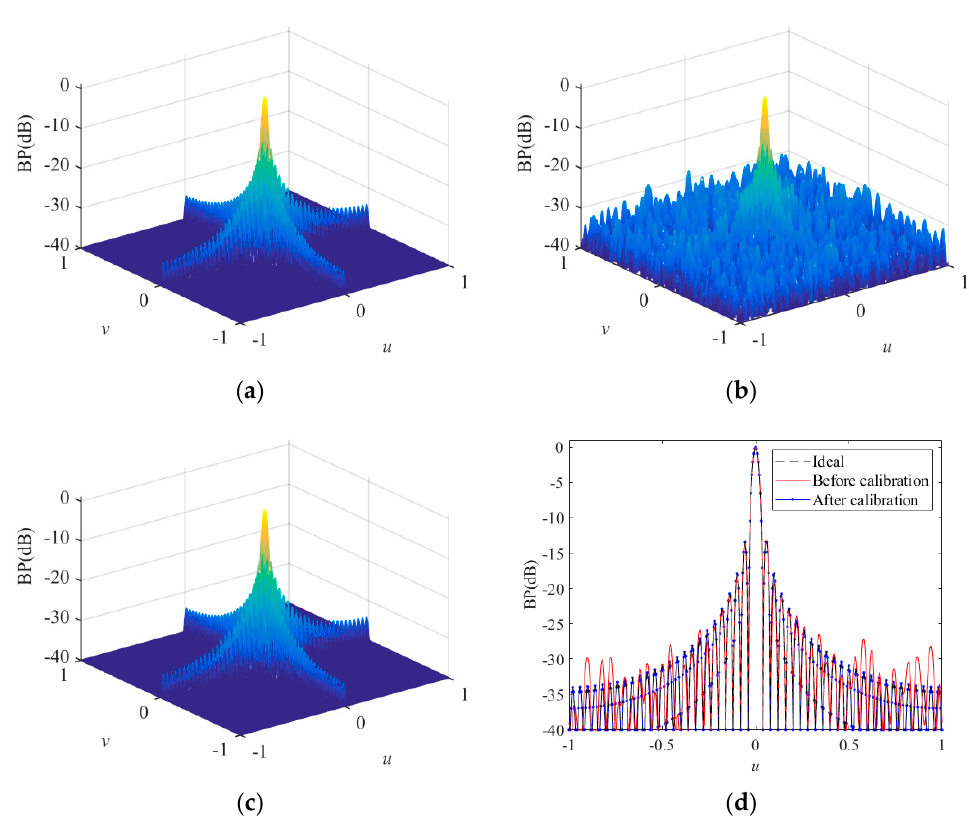
Figure 5. Comparison of beam pattern via calibration: ( a ) ideal; ( b ) before calibration; ( c ) after calibration; ( d ) comparison of 2D beam pattern.